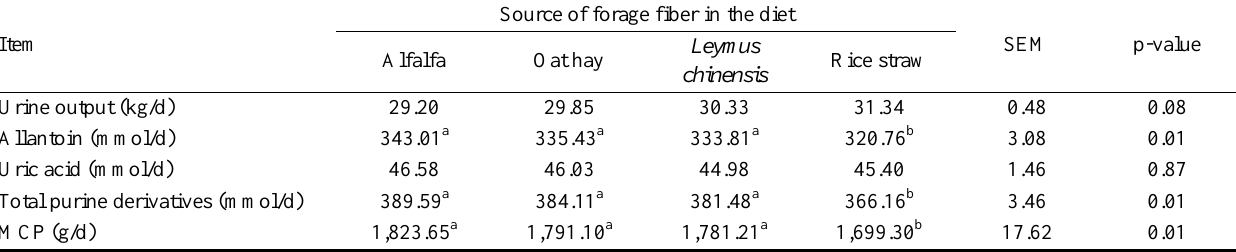
Table 5. Urine output, urinary purine derivative excretion, and microbial N supply in dairy cows fed diets containing alfalfa hay, oat hay, Leymus chinensis , and rice straw as dietary forage sources Source of forage fiber in the diet Item